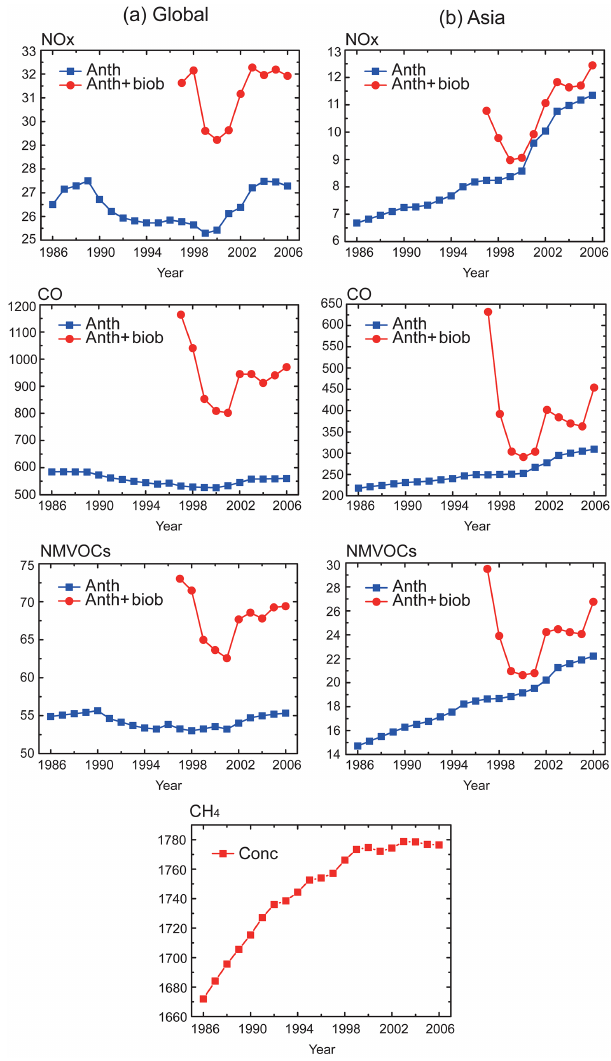
Figure 1. The evolution of annual anthropogenic and biomass burn- ing emissions summed globally and for Asia (60–150 ◦ E, 10 ◦ S– 55 ◦ N) for NO x (TgNyr − 1 ) , CO (TgCOyr − 1 ) , and NMVOCs (TgCyr − 1 ) from 1986–2006. The blue squares represent anthro- pogenic emissions, and the red circles represent the sum of anthro- pogenic emissions and biomass burning emissions. The last panel shows the evolution of global CH 4 abundance (ppbv) from 1986– 2006.